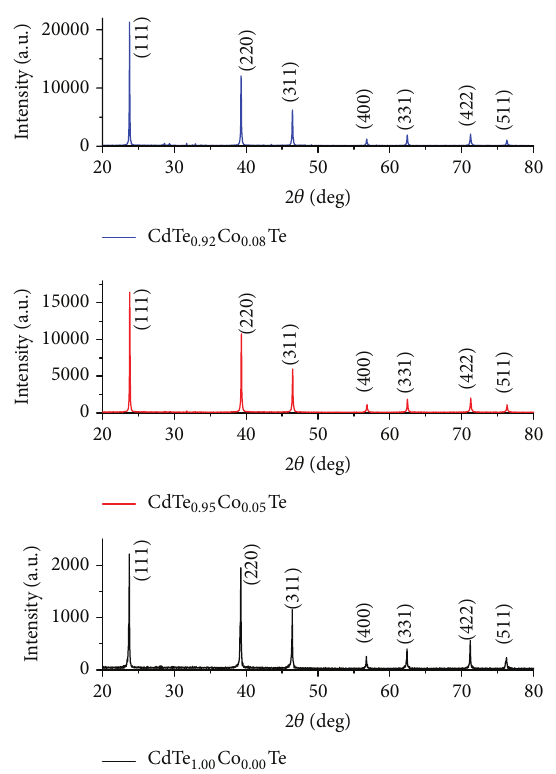
Figure 1: X-ray diffraction pattern of Cd 1−𝑥 Co 𝑥 Te alloy powders.